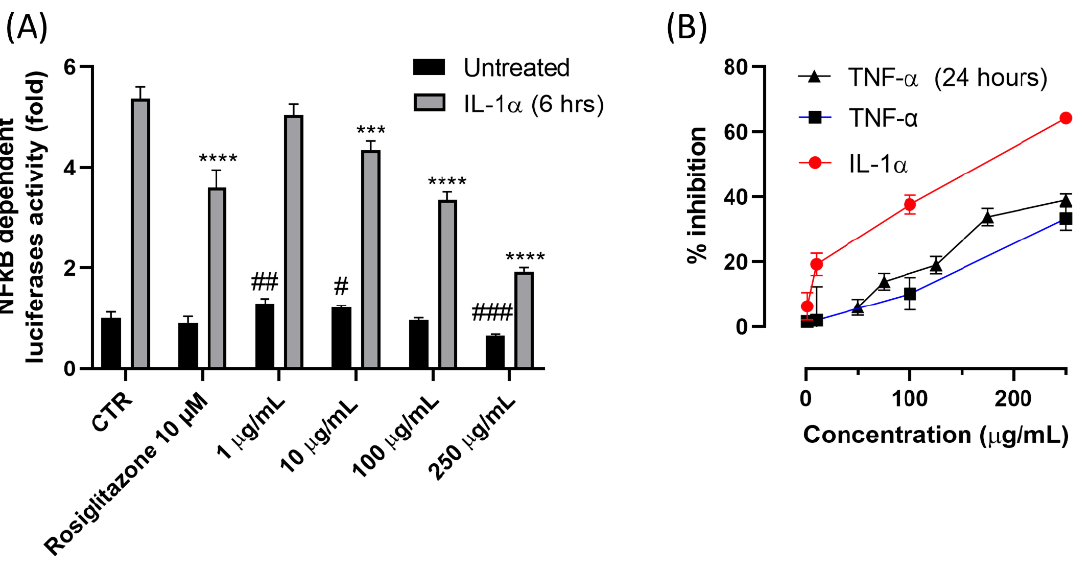
Figure 4. Dose-dependent anti-inflammatory activity of TAP. Activity was tested in R3/1 with the luciferase gene reported for NF- κ B nuclear translocation. ( A ) The NF- κ B-dependent luciferase activity in cells incubated in the absence (black columns) and presence (gray columns) of IL-1 α and treated with TAP in a 1–250 µ g/mL concentration range. Rosiglitazone 10 µ M was used as a positive control. ( B ) The dose-dependent effect of TAP on the NF- κ B-dependent luciferase activity of cells challenged for 6 h with IL1- α , and for 6 and 24 h with TNF- α , (*** p < 0.001, **** p < 0.0001—# p < 0.05, ## p < 0.005, ### p < 0.001).